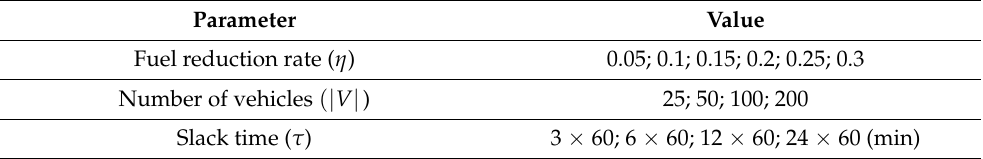
Table 4. Parameters of simulation experiment.